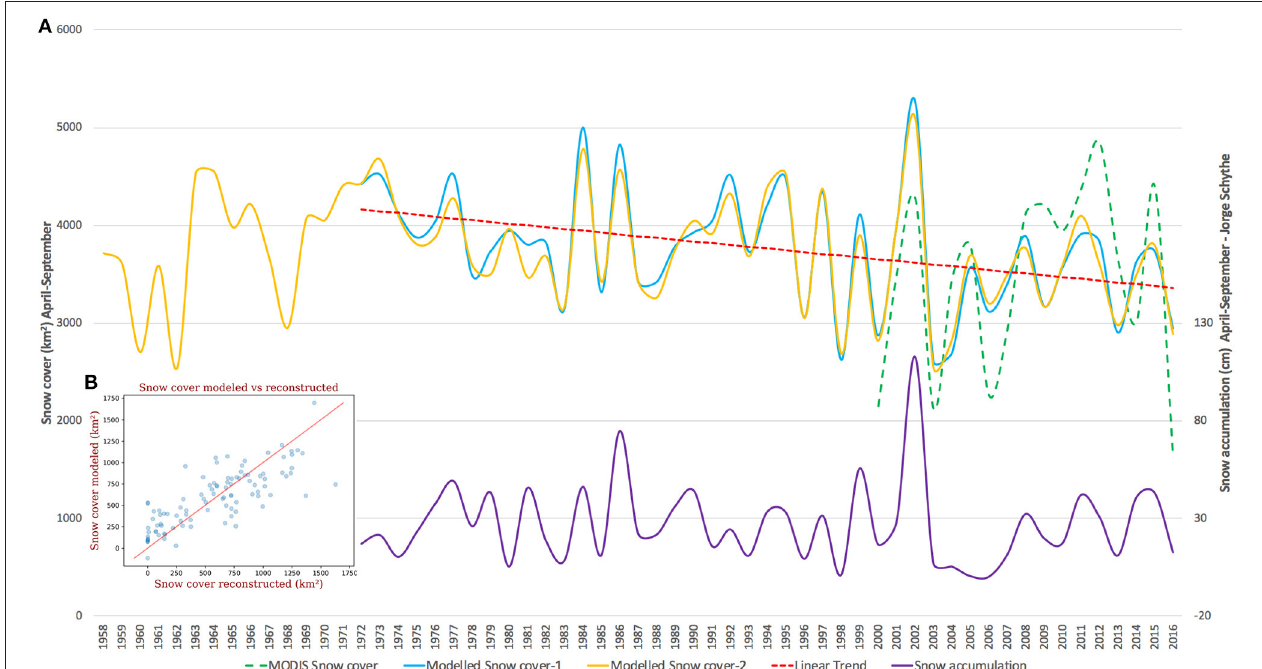
FIGURE 13 | (A) Upper section. Annual (April–September sums) of NDSI snow cover reconstructed for the Macro zone from MODIS data (dashed green) for the period 2000–2016. The annual (April–September sums) of snow cover modeled with Equation (6) (snow cover as a function of monthly mean temperature at Punta Arenas Airport and snow accumulation at Schythe station) is shown in light blue for the 1972–2016 period, while the red dashed line represents its linear trend. The annual (April–September sums) of snow cover modeled with Equation (7) (snow cover as a function of monthly mean temperature and snow accumulation modeled at Punta Arenas Airport) is shown in orange for the 1958–2016 period. The trend of the modeled snow cover is − 19% for the period 1972–2016 ( p < 0.05). Lower section. The annual (April–September) snow accumulation at Jorge Schythe station is shown as a purple curve. The inset (B) shows a scatter plot between the monthly values of modeled snow cover area on the Macro zone and the reconstructed snow cover from MODIS data for the 2000–2016 period, with R 2 = 0.62 and p <